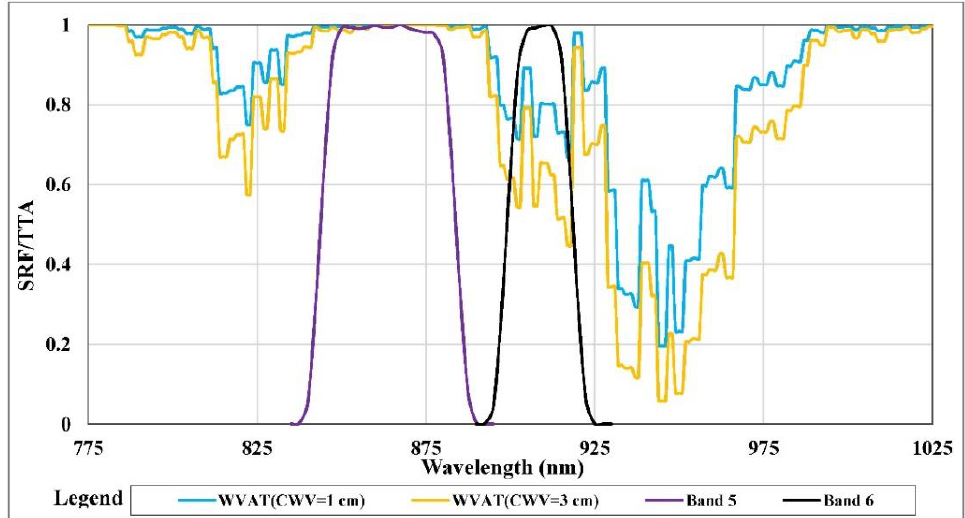
Figure 1. The SRFs of two bands of PSAC used for CWV retrieval. The first line in the legend (blue line) represents the water vapor absorption transmittance (WVAT) of the atmosphere when the view zenith angle (VZA) and solar zenith angle (SZA) are equal to 0 and CWV is equal to 1 cm. The second line (yellow line) represents the WVAT when VZA and SZA are equal to 0 and CWV is equal to 3 cm. The next two are SRFs of the two bands of PSAC used for CWV